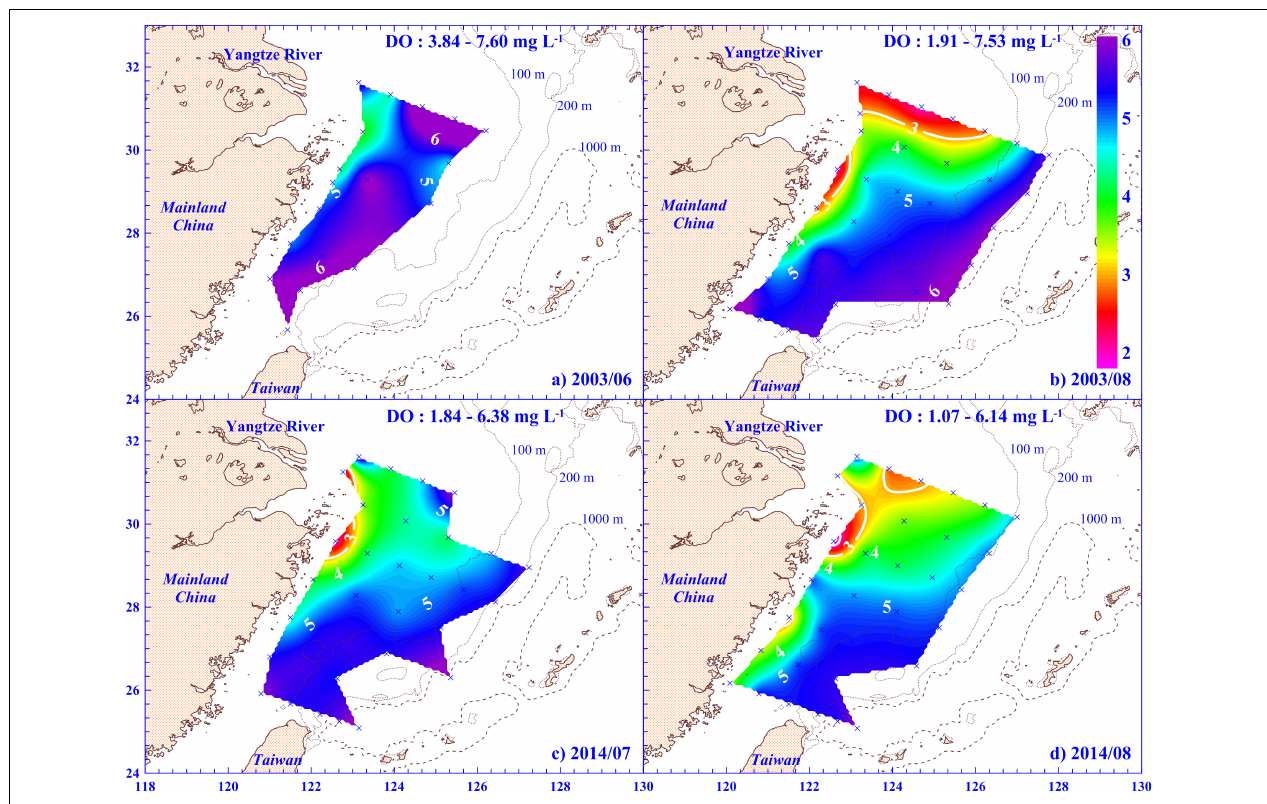
FIGURE 2 | Contours of concentration of dissolved oxygen (DO) in bottom water column or at 100 m if water column depth was > 100 m in East China Sea in (a) June and (b) August 2003 and (c) July and (d) August 2014. Contour lines of DO = 3 mg L − 1 are provided in white bold for reference. Please note that panels (a,b) were modified from Chen et al.